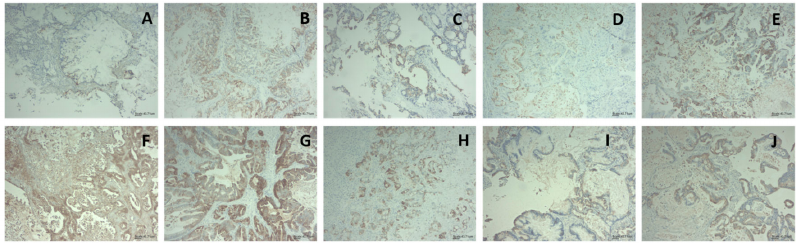
Immunohistochemical staining of PDX tumour sections using primary antibody Anti-Mitochondria antibody 113-1, where panel A shows PIN 065; B PIN 080; C PIN 089; D PIN091; E PIN 099; F PIN 120; G PIN 140; H PIN 141; I PIN 160; J PIN 161. Magnification for all images is 10 × (scale 43.71 µ m) and an antibody dilution of 1 /